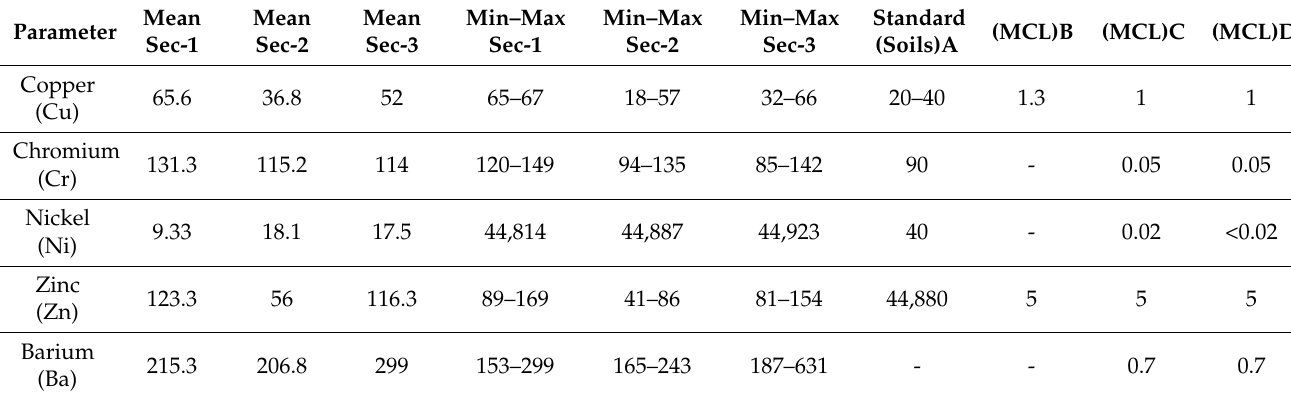
Table 3. Criteria of heavy metal concentrations in normal soils and drinking water. A = Standard values for normal soils; B = Maximum contaminant level (MCL); C = Maximum contaminant level (MCL); D = Maximum contaminant level